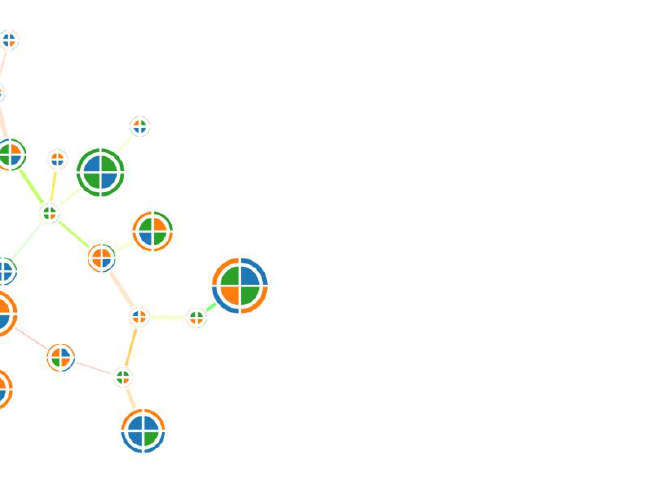
Figure 22. An example of a glyph with four kinds of parameters. The inner part of the glyph displays the current values, while the outer part shows the previous ones.